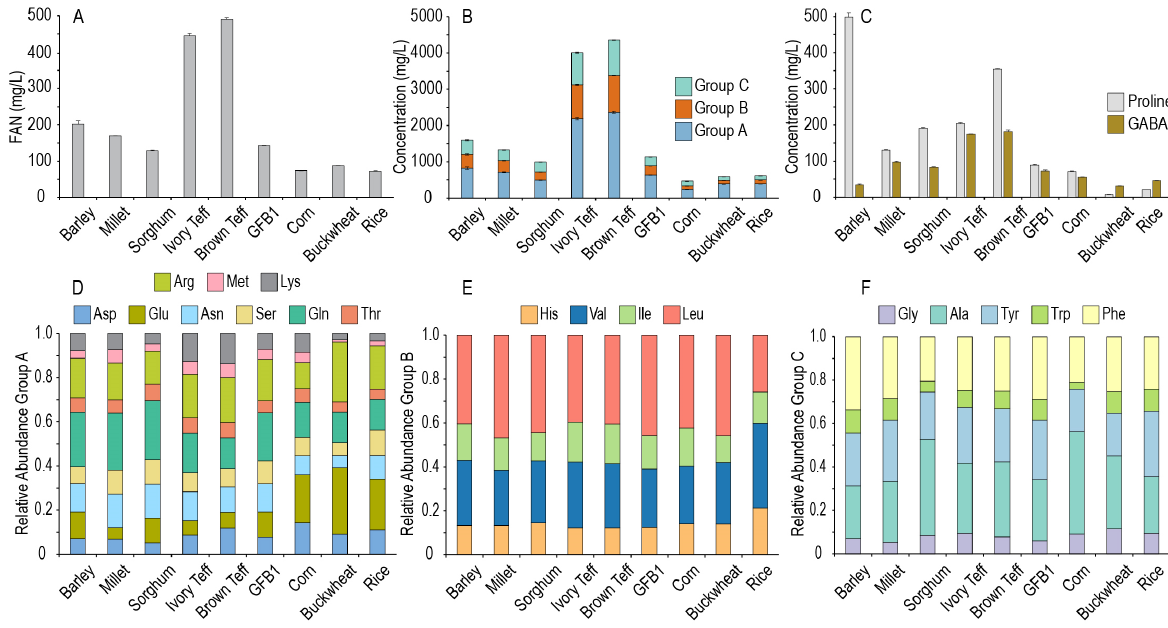
Figure 1. FAN measurements of GF worts compared to barley ( A ); sum of usable amino acids by utilization group ( B ); proline and GABA concentrations ( C ); and relative abundances of each amino acid within the utilization group, Group A ( D ), Group B ( E ), and Group C ( F ) of barley infusion mash samples and GF ExGM mash samples. All samples had a final liquor-to-grist ratio of 6:1. As wort fermentations require both sufficient concentrations of yeast assimilable sugar and nitrogen sources, the FAN and amino acid profiles of GF worts made by the ExGM mashing procedure [20] were investigated. While several of these worts from GF malts (millet, sorghum, ivory teff, brown teff, and GFB1) contained similar or even higher concentrations of FS compared to a barley-derived wort prepared using a common iso-